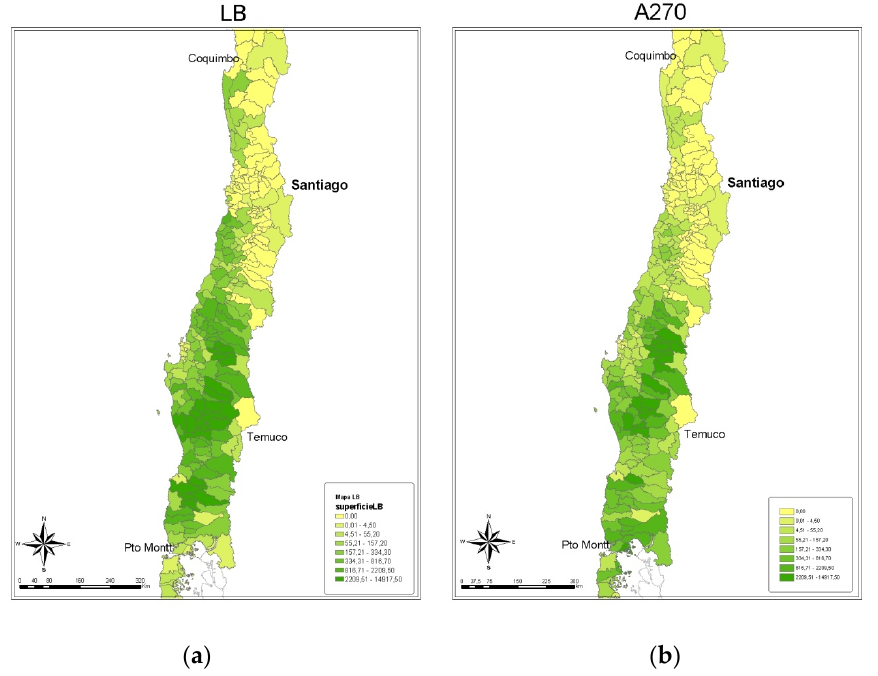
Figure 1. Hectares under wheat at baseline ( a ) and in severe climate-change scenarios in 2070 ( b ).